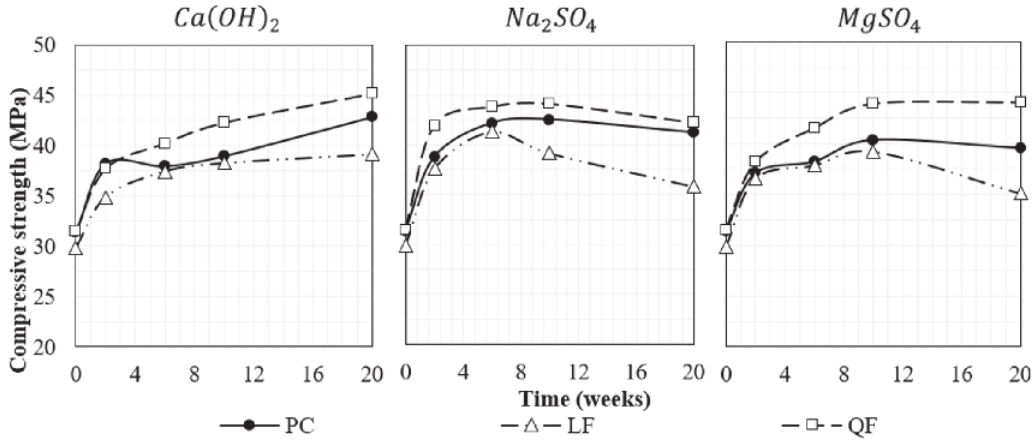
Compressive strength of the samples up to 20 weeks of exposure in the three different solutions [Ca(OH) , Na SO and MgSO 2 2 4 4